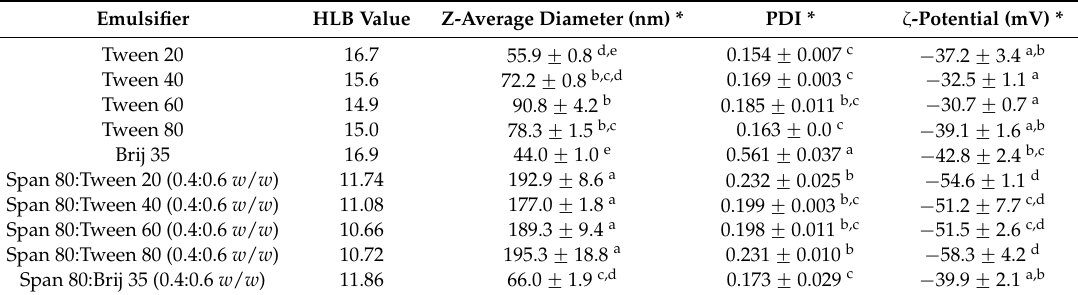
Table 1. Z-average diameter (nm), PDI and ζ -potential (mV) of TRF nanoemulsions prepared with different emulsifiers (mean ˘ S.D., n =